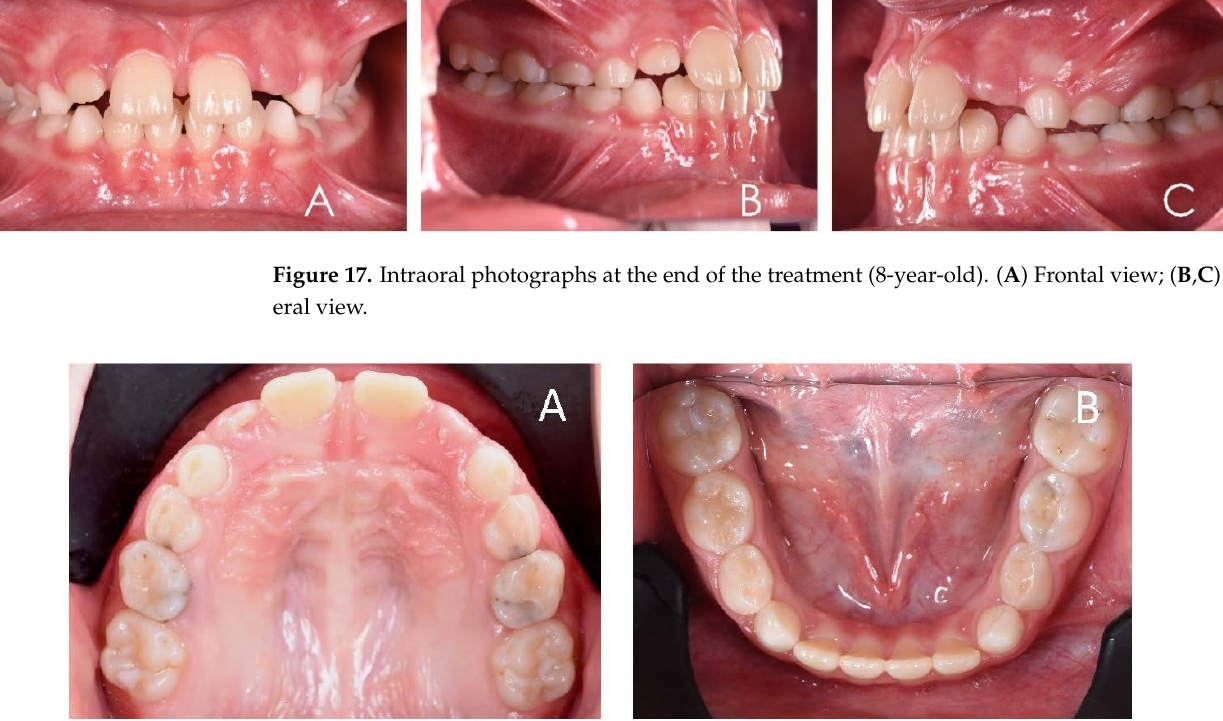
Figure 18. Final occlusal photos of dental arches (8-year-old). ( A ) Upper arch; ( B ) lower arch.